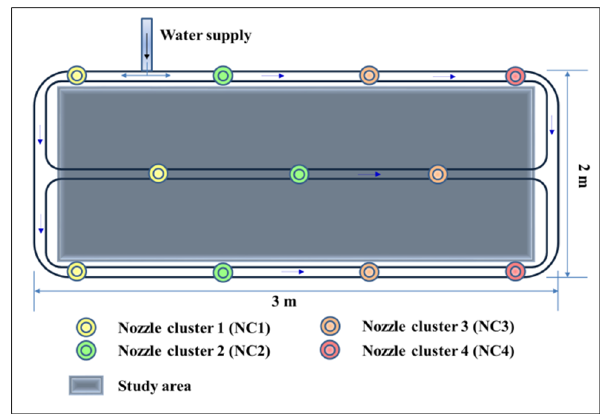
Figure 4. Nozzle distribution of rainfall simulator over the soil